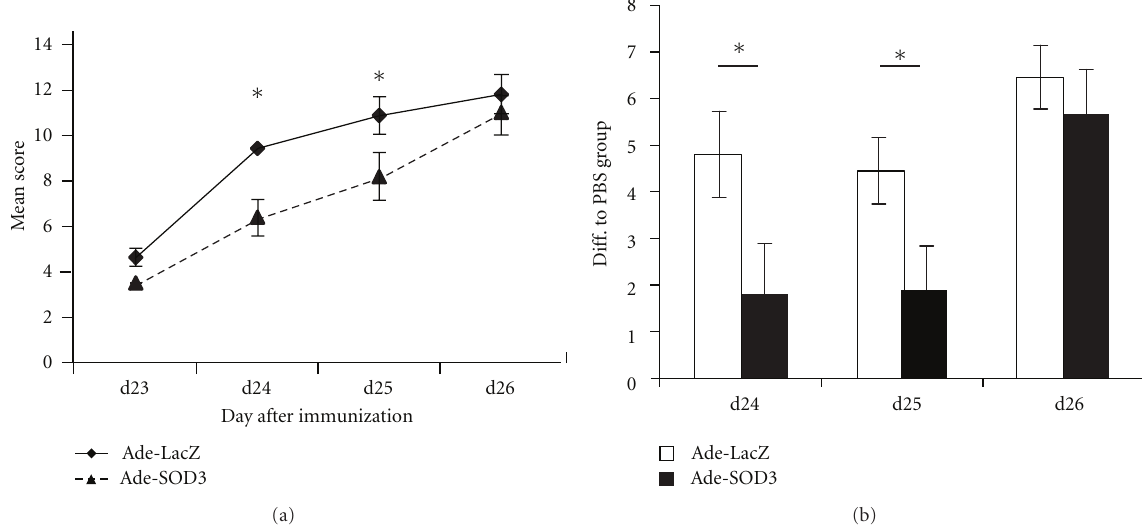
Figure 3: SOD3 downregulated arthritis in the absence of functional NOX2 complex. Arthritis severity was significantly reduced in Ade- SOD3-treated paws of mice lacking functional oxidative burst when compared to the control vector-treated paws (a). Shown is pooled data from two independent experiments (Ade-SOD3 n = 22, Ade-lacZ n = 23). The di ff erence in arthritis score in the treated paw between the PBS-treated control mice ( n = 10) and Ade-SOD3-treated mice was smaller than the di ff erence between PBS-treated and Ade-LacZ-treated mice at days 24 and 25